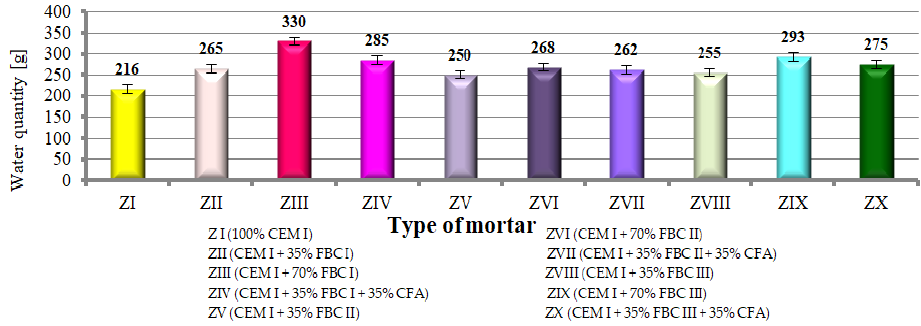
Figure 8. Quantity of water required to reach the consistency of the reference mortar for mortars containing FBC fly ashes and mixtures containing FBC fly ashes and CFA.